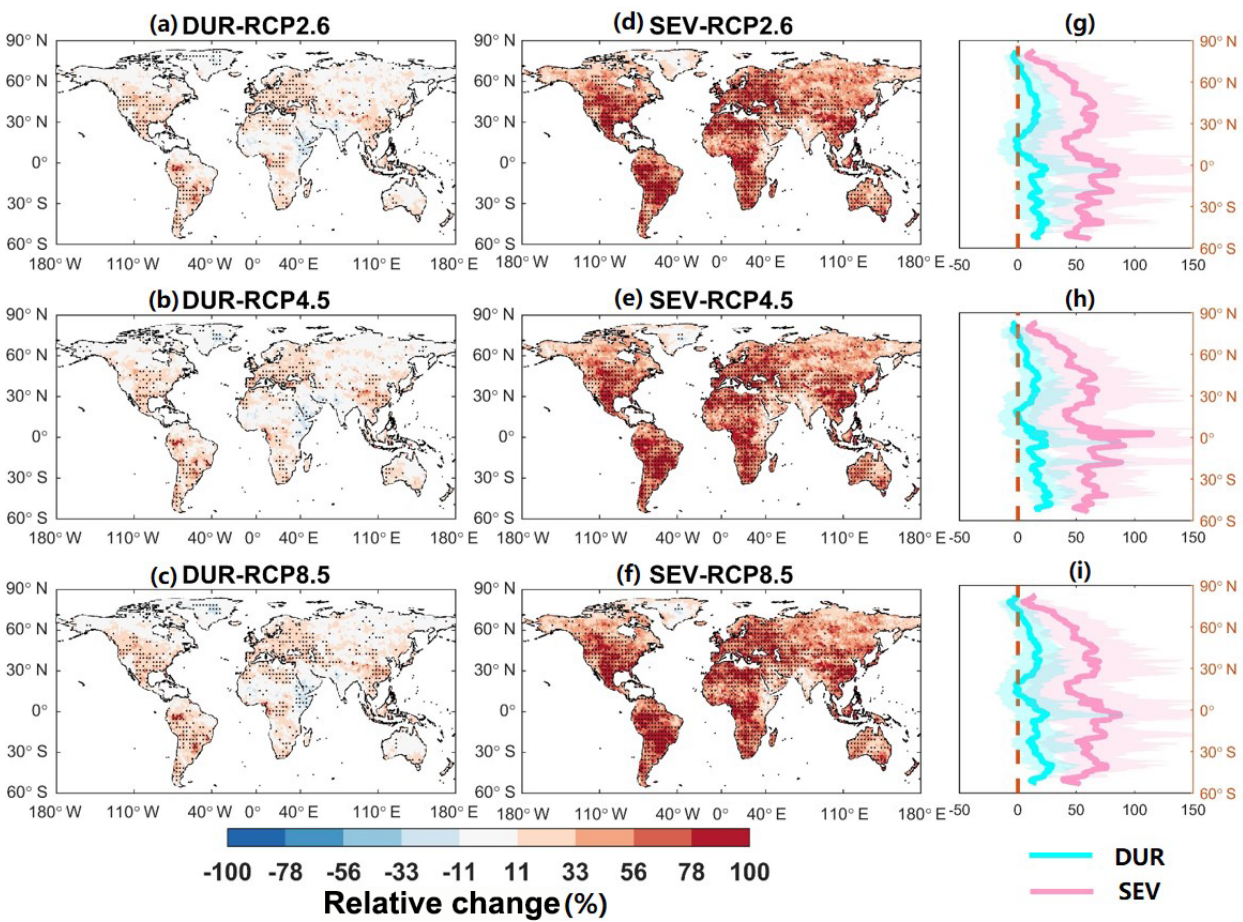
Figure 4. Projected changes in drought duration and severity under the 1.5 ◦ C warming